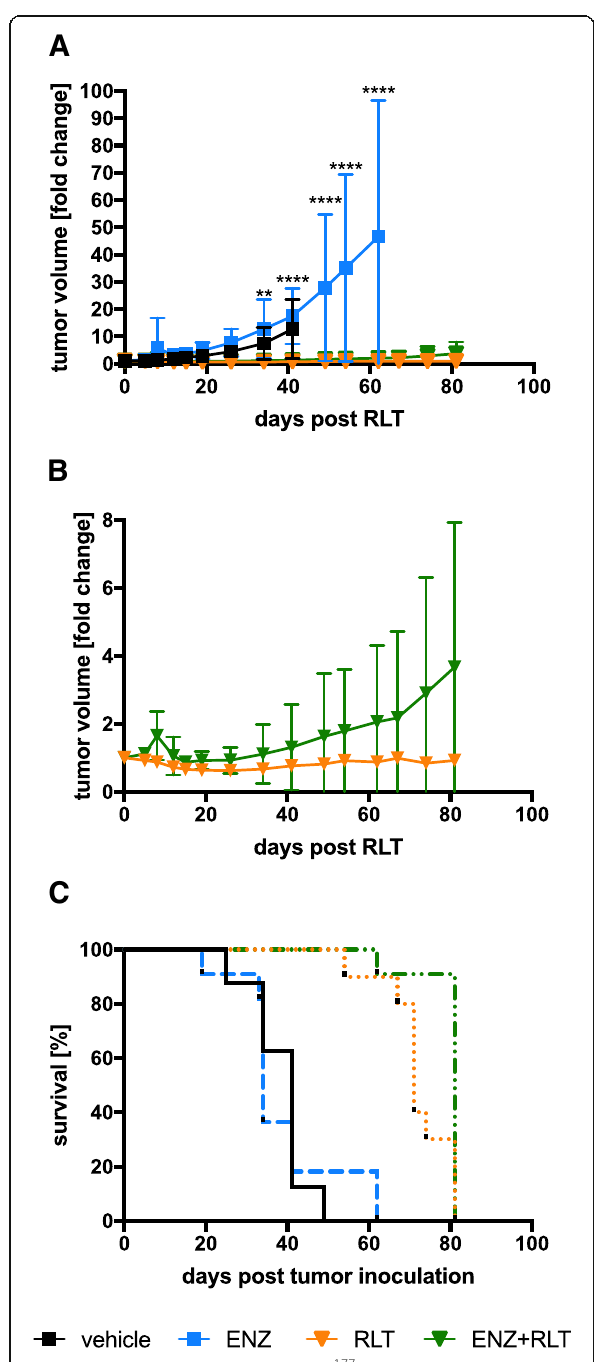
Fig. 5 Efficacy of combined ARB and 177 Lu-PSMA617 radioligand therapy. Tumor volume was determined by CT. The fold-change in tumor volume after RLT (day 1) administration related to the tumor volume immediately prior to RLT (day 0) is shown. The last dose of ENZ was given at day 0. Data are represented as mean ± SD. a Tumor volume change in all groups. Asterisks indicate significance in vehicle and ENZ groups vs. RLT and ENZ+RLT groups, respectively (**** p < 0.0001; ** p < 0.01). b Tumor volume change in the RLT and ENZ+RLT groups ( p = not